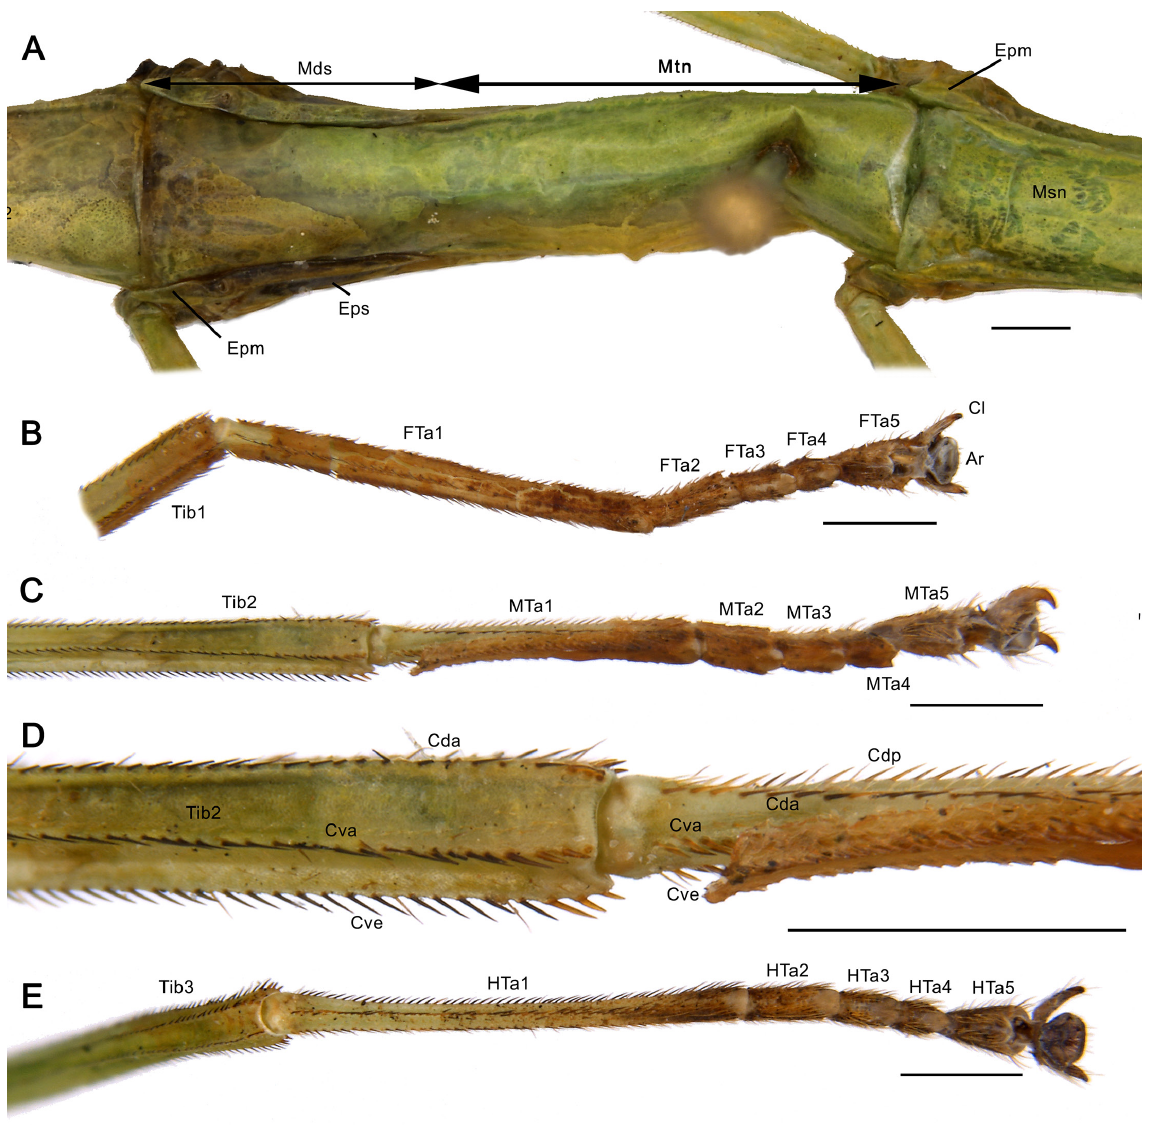
Fig. 22. Arumatia crassicercata Ghirotto, Crispino & Engelking gen. et sp. nov., holotype, ♀ (MZUSP 0812), thorax and leg morphology. A . Metathorax and median segment in dorsal view, arrows indicate the length of each segment. B . Right fore tarsus (mirrored), ventral view. C–D . Left mid tarsus, anteroventral view, detail in D. E . Right hind tarsus, ventral view. Abbreviations: Ar = arolium; Cda = dorsal anterior carina; Cdp = dorsal posterior carina; Cl = claw; Cva = ventral anterior carina; Cve = ventral carina; Epm = epimeron; Eps = episternum; FTa = fore tarsomere; HTa = hind tarsomere; Mds = median segment; Msn = mesonotum; MTa = mid tarsomere; Mtn = metanotum; Tib = tibia. Scale bars: 1